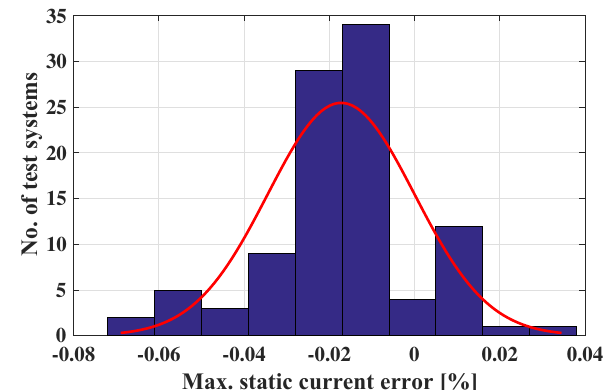
Figure 11. Maximum current deviation after calibration in thermal steady state for 100 test systems.